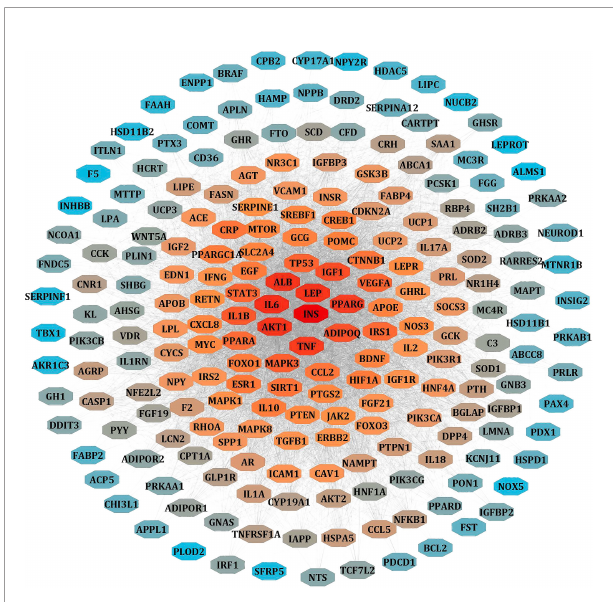
FIGURE 3 | PPI network of LR-induced obesity. The node color red to blue represents the descending order of degree values.